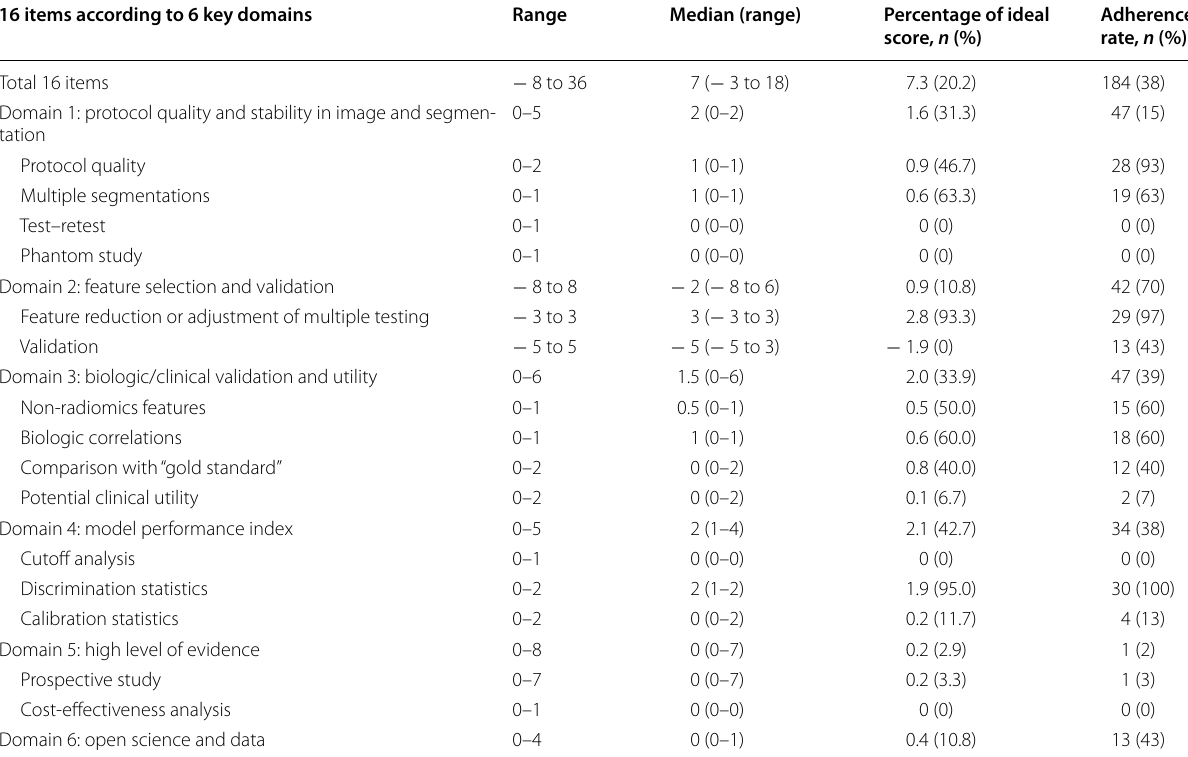
RQS Radiomics Quality